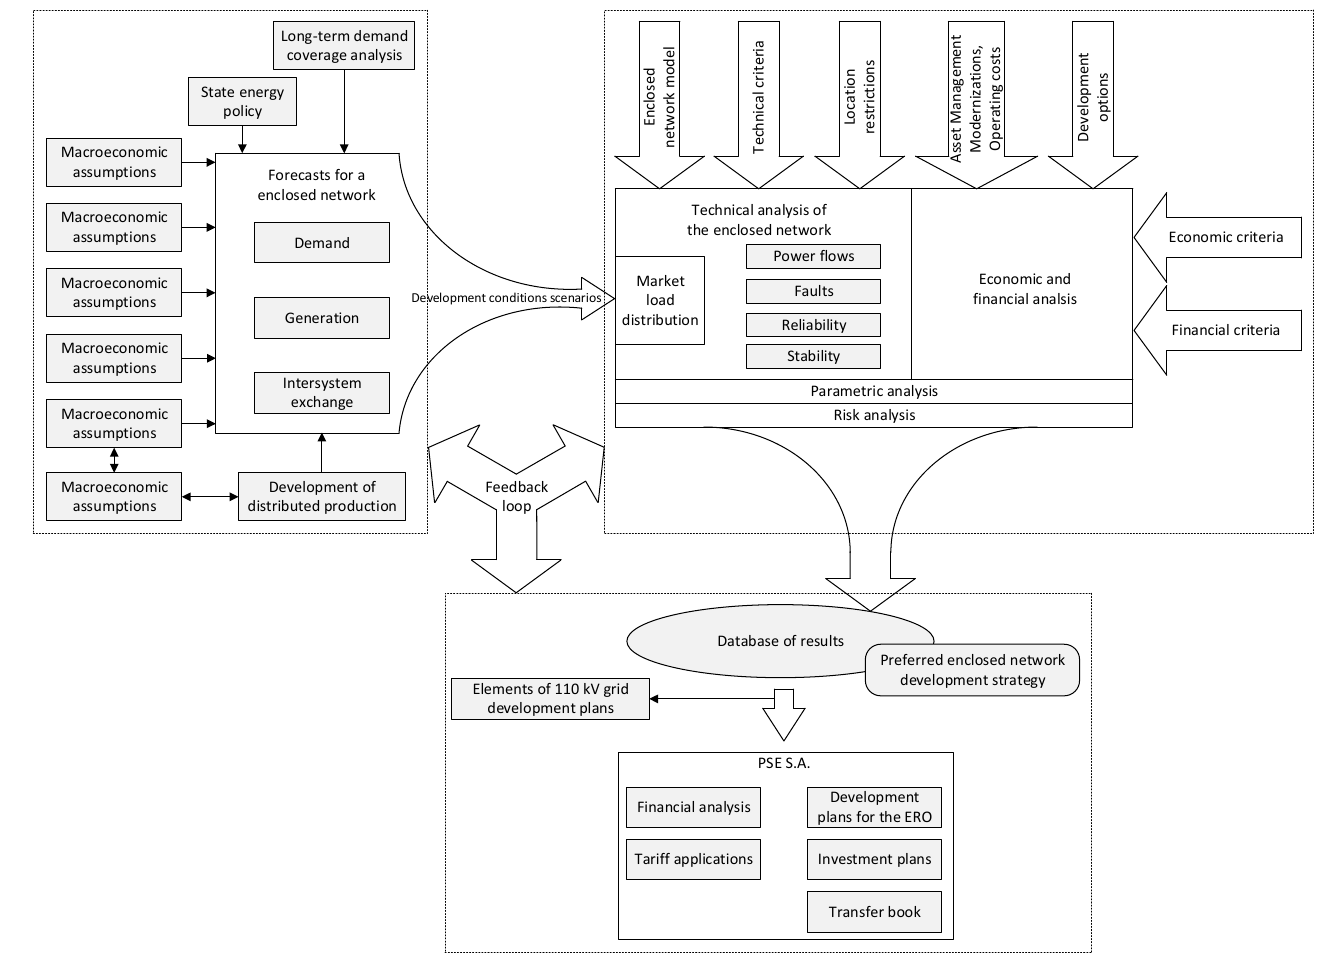
Figure 2. Diagram of the transmission grid development planning process implemented on the PRiMSP platform.